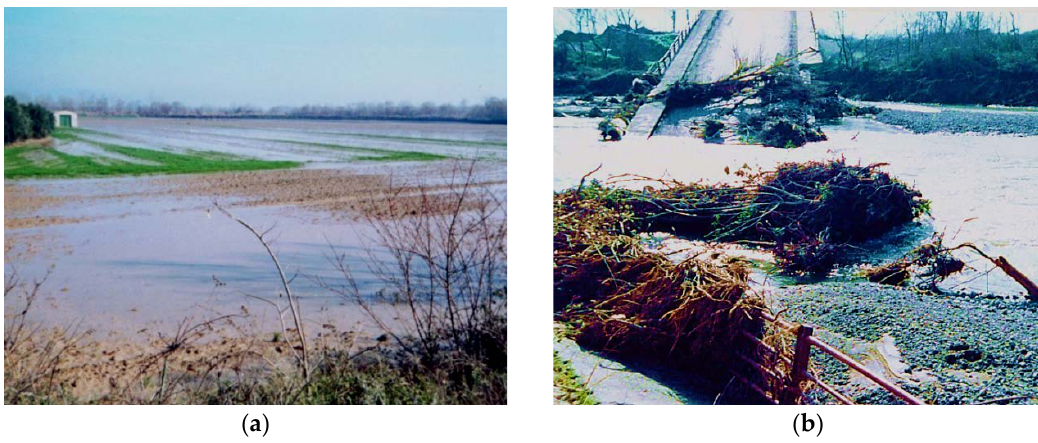
Figure 11. Photos demonstrating the severe flash-flood events that occurred ( a ) on February 1st 2015 and ( b ) on January 14th 1997. In the latter case, extended destruction occurred, and six bridges of the river collapsed.